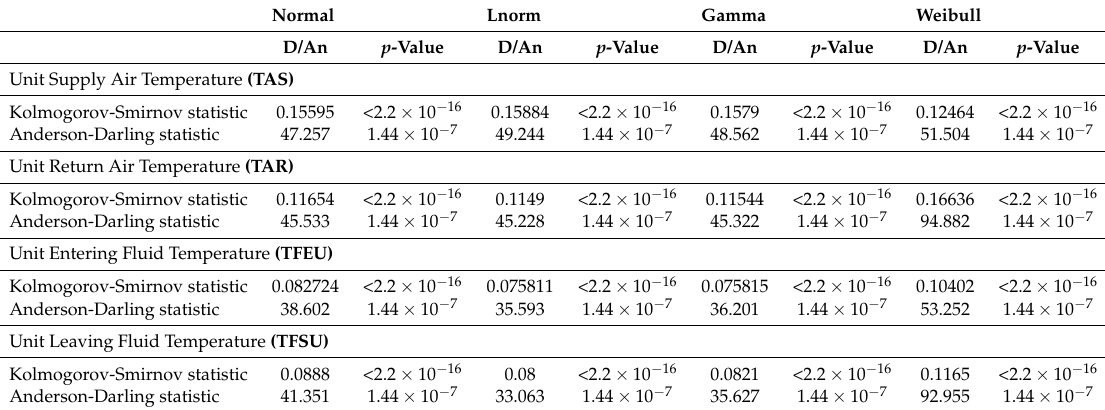
Table 2. Goodness-of-fit